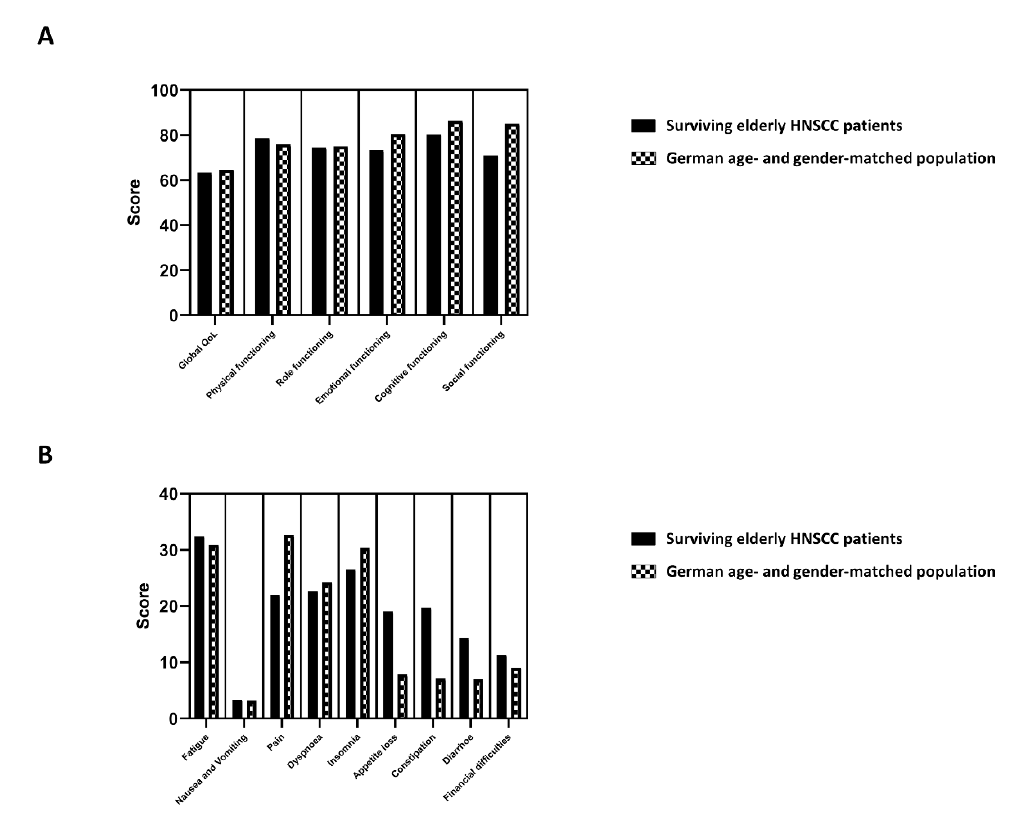
Figure 1. Comparison between surviving elderly HNSCC (head-and-neck squamous cell carcinoma) patients and matched patients from the German general population (with the same age and gender) regarding the functioning subscales ( A ) and the symptom subscales/items ( B ) of the EORTC QLQ-C30 questionnaire. Bars represent the mean values of the different subscales. General population norm data for Germany are obtained from [23].